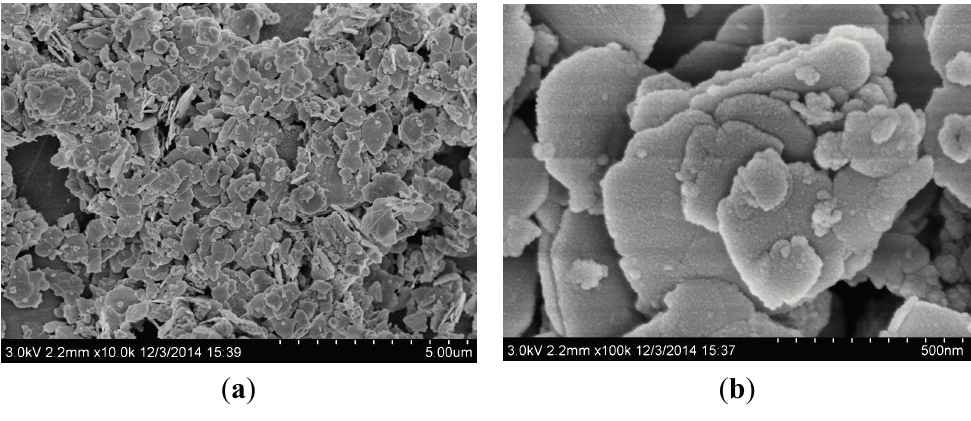
Figure 2. The SEM images of BiOCOOH.